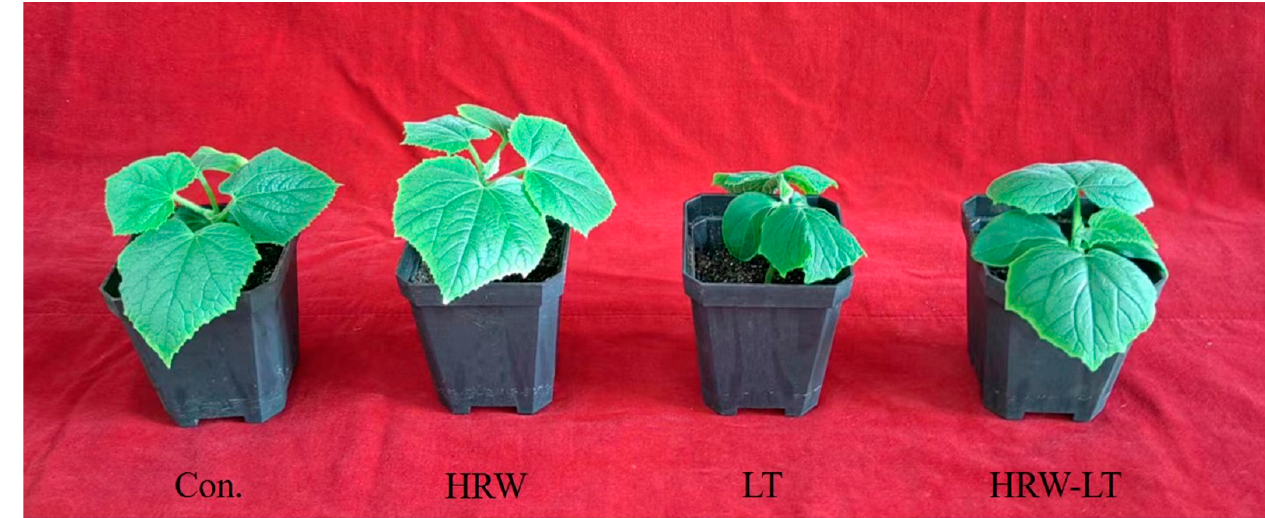
Figure 1. The phenotype of cucumber seedlings under chilling stress after HRW treatment. Con.: control; HRW: treatment by hydrogen-rich water; LT: treatment by chilling stress; HRW-LT: chilling stress after HRW treatment.